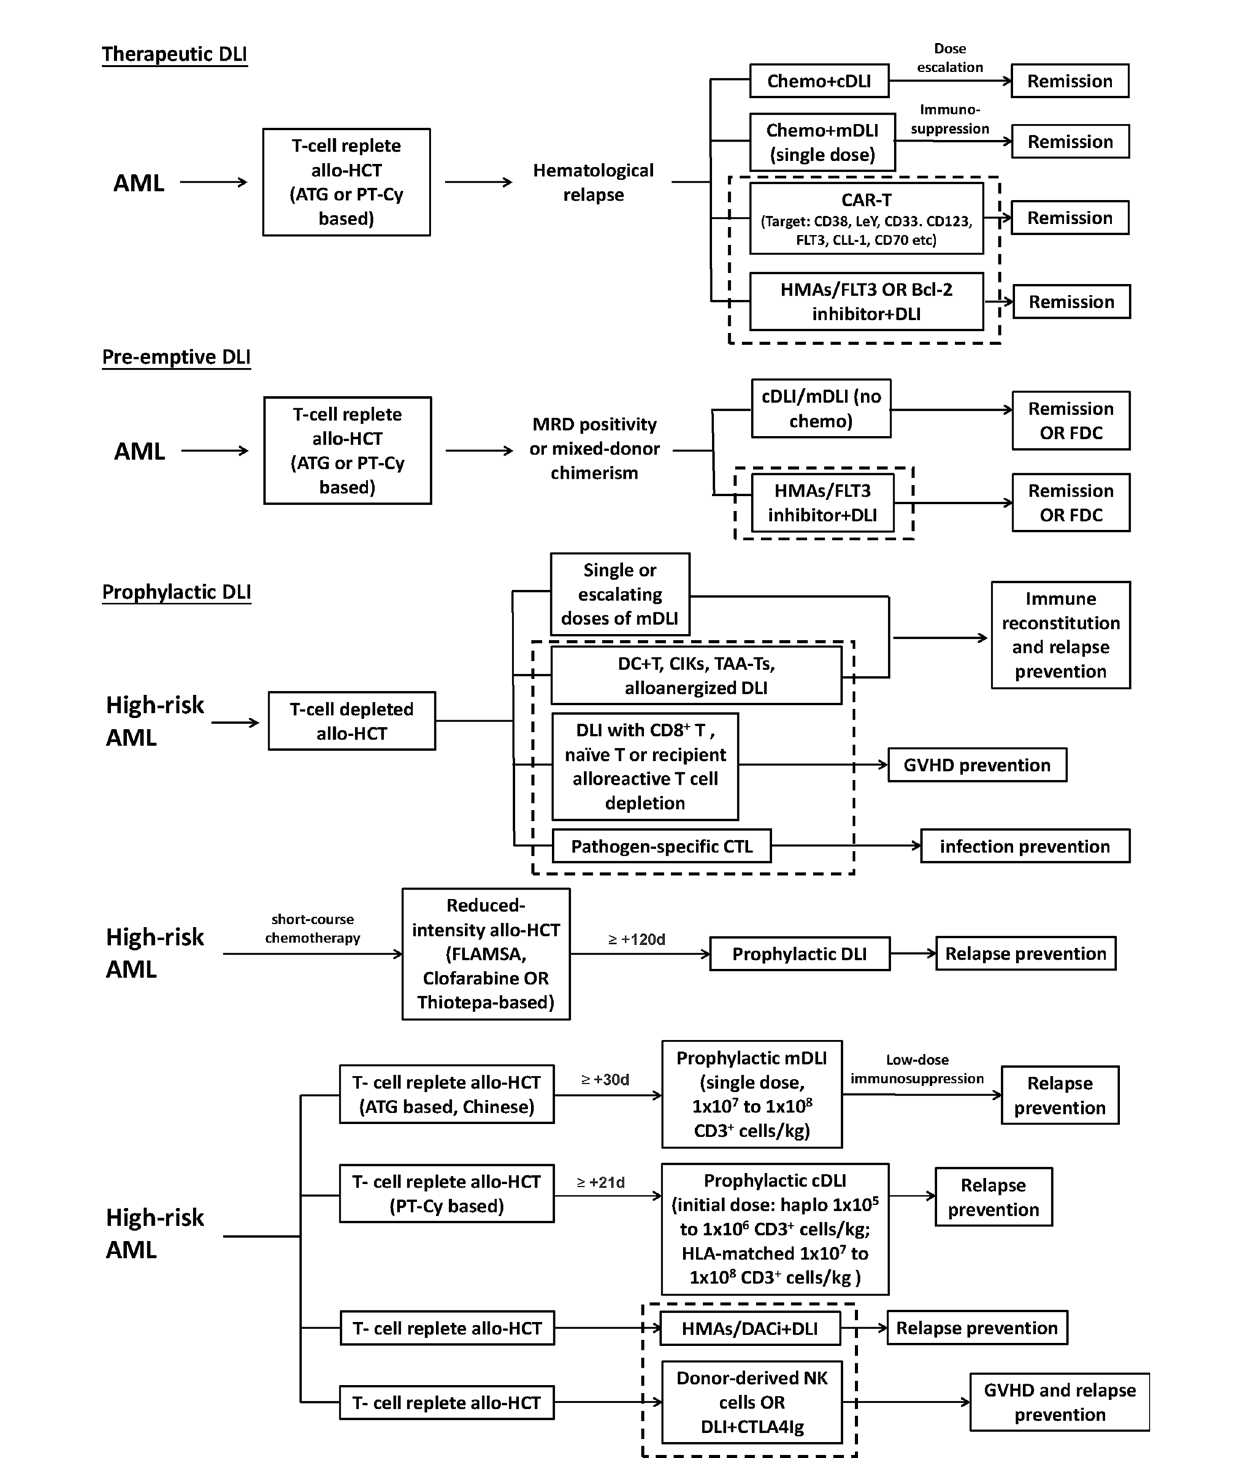
FIGURE 1 | Recommended strategies to optimize the donor lymphocyte infusion (DLI), including DLI regimen and protocol improvement, additional use of novel drugs, and cell engineering. The area within the dotted bordered square indicate strategies, including novel drugs and cell engineering. High-risk AML represents those de fi ned to have a higher risk of relapse in different studies. cDLI, DLI prepared by leukapheresis of unstimulated peripheral blood; mDLI, DLI derived from peripheral blood stem cells mobilized by granulocyte colony-stimulating factor; HMAs, hypomethylating agents; FDC, full donor chimerism; CIK, cytokine-induced killer cells; TAA-T, tumor-antigen-speci fi c T cells; FLAMSA, condition regimen including fl udarabine, cytarabine, and